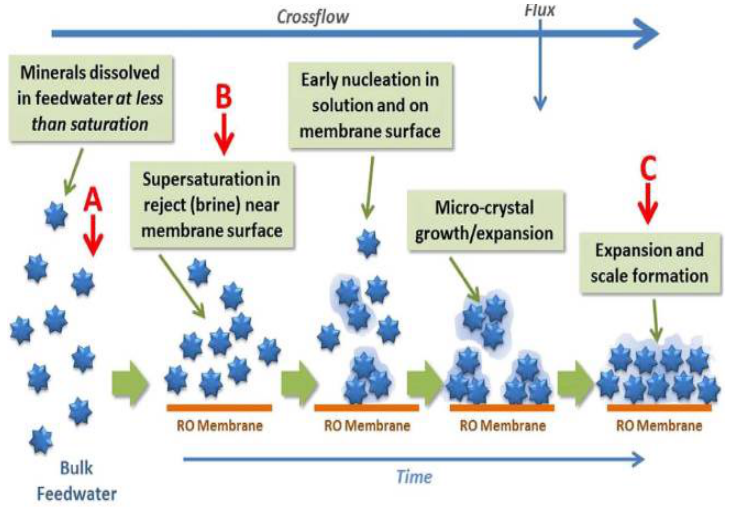
Figure 3. Schematic diagram of the key steps (A, B and C) in the formation of scale on the surface of the RO membrane over time [25].